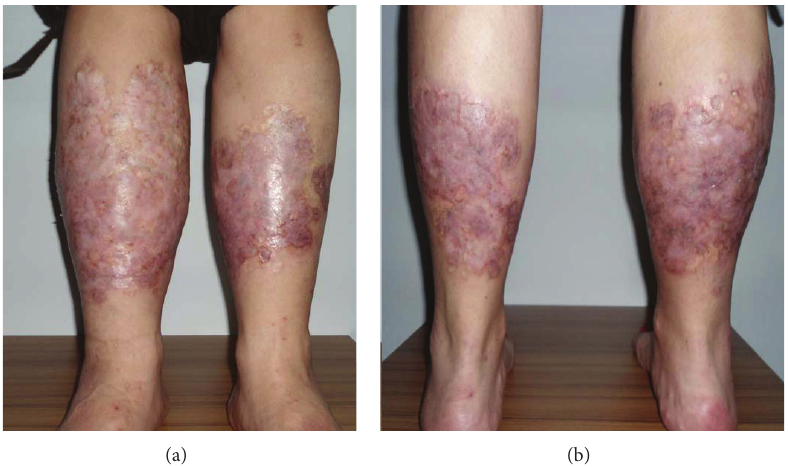
Figure 3: Remitted bilateral non-ulcerated and nonoozing plaques over legs after a year from the